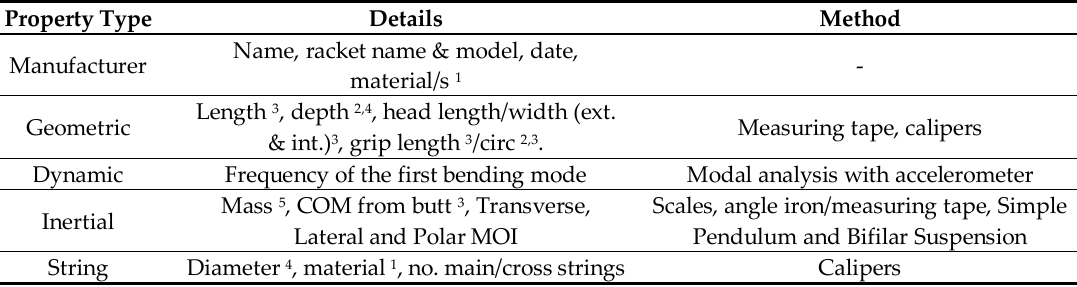
Table 1. Properties documented and measured for each